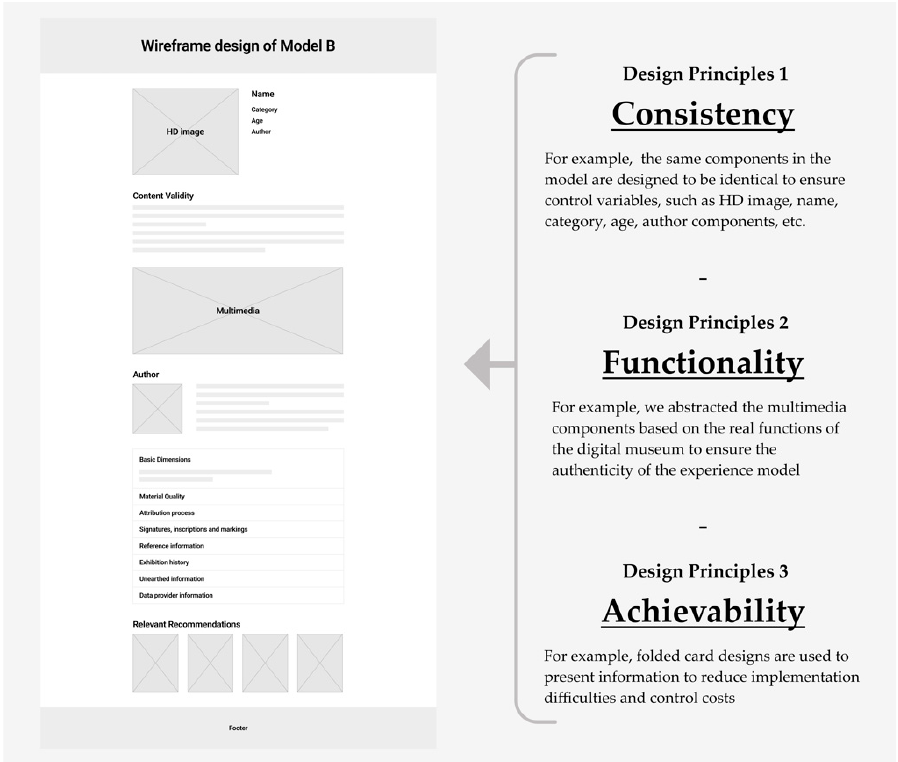
Figure 4. Design principles and their application, taking Model B as an example.